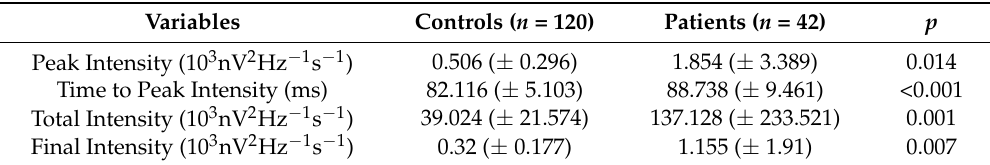
Table 4. Summary of the intensity analysis.